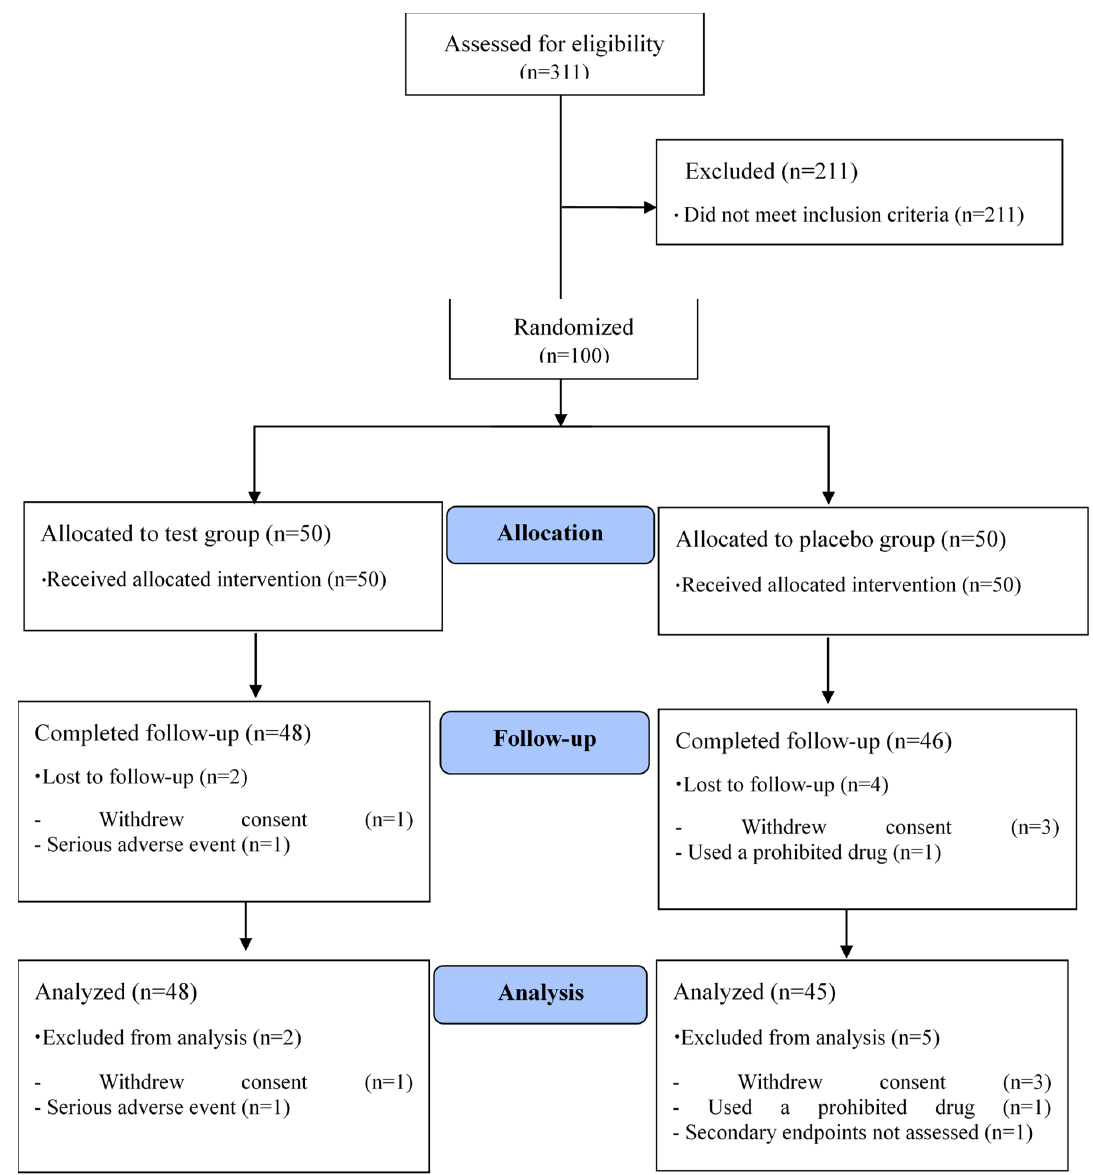
Figure 1. Flow diagram of the participants in this human study. Table 2. Baseline general characteristics of the subjects.